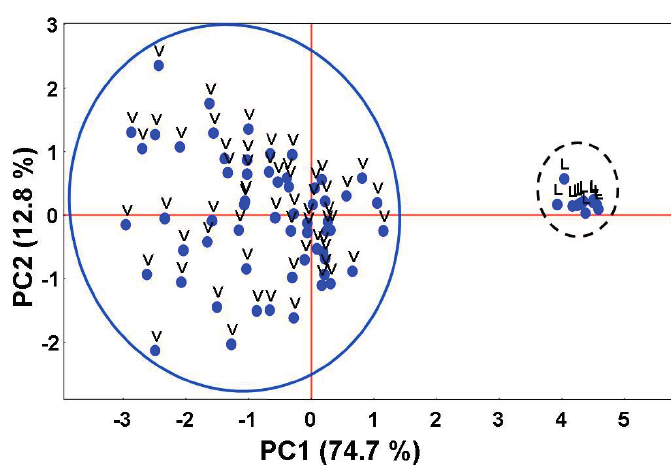
Figure 8. Representation of samples in the reduced bi-dimensional principal factor space. Samples belonging to class V are well-separated from those belonging to class V (dotted